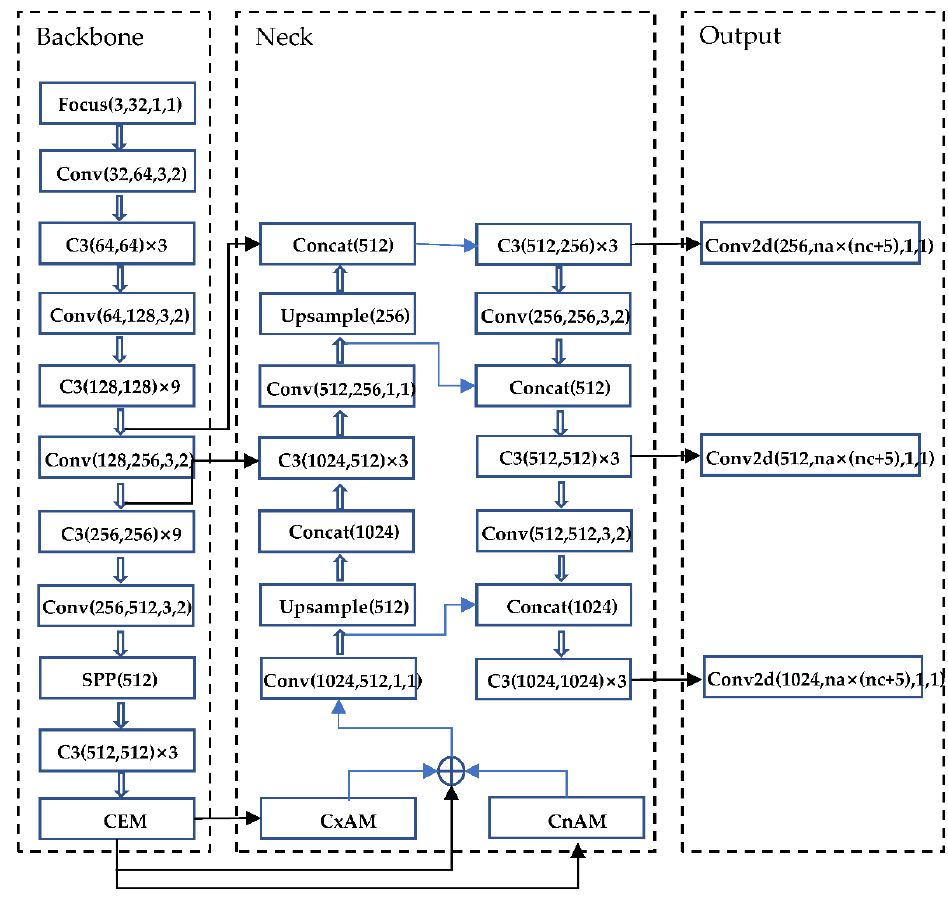
Figure 12. YOLOv5-AC structure diagram.